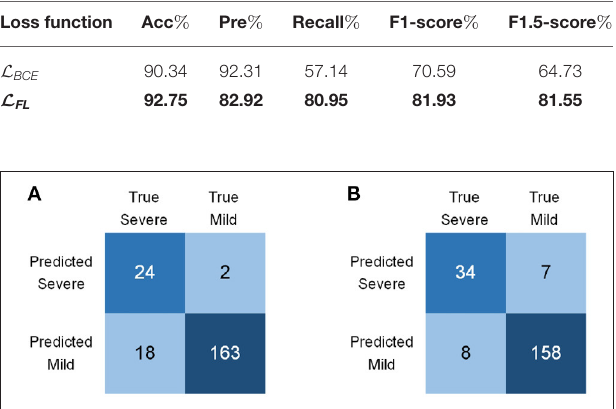
TABLE 4 | Results of different loss functions in terms of Acc, Pre, recall, and F-score.